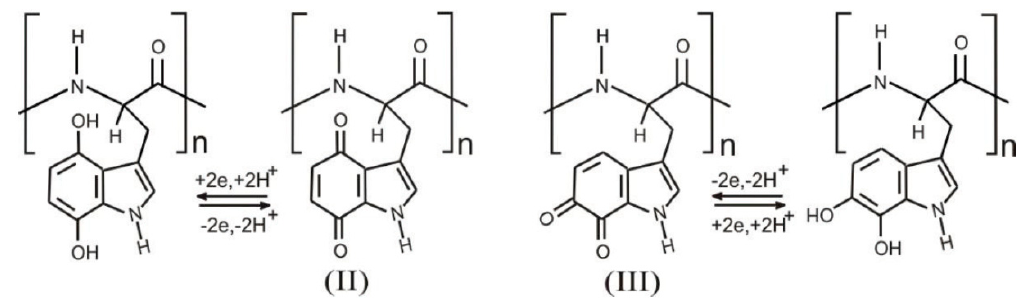
Figure 26. Oxidation products of a peptide homopolymer of tryptophan. After a first electrooxidation step, the fibers become electroactive due to the presence of the para- and orthoquinone groups. Reproduced from [79]. Creative Commons Attribution License.